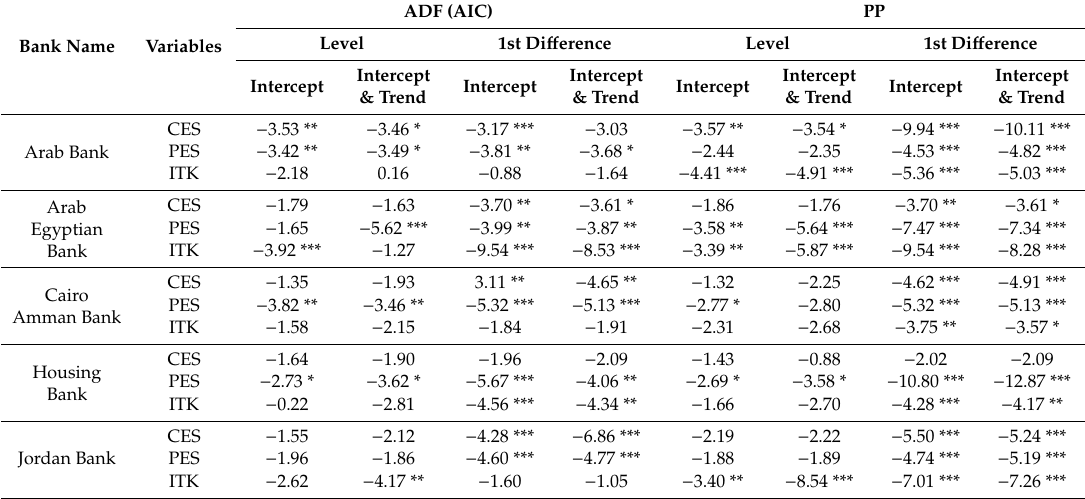
Table 4. Unit root statistics for variables of